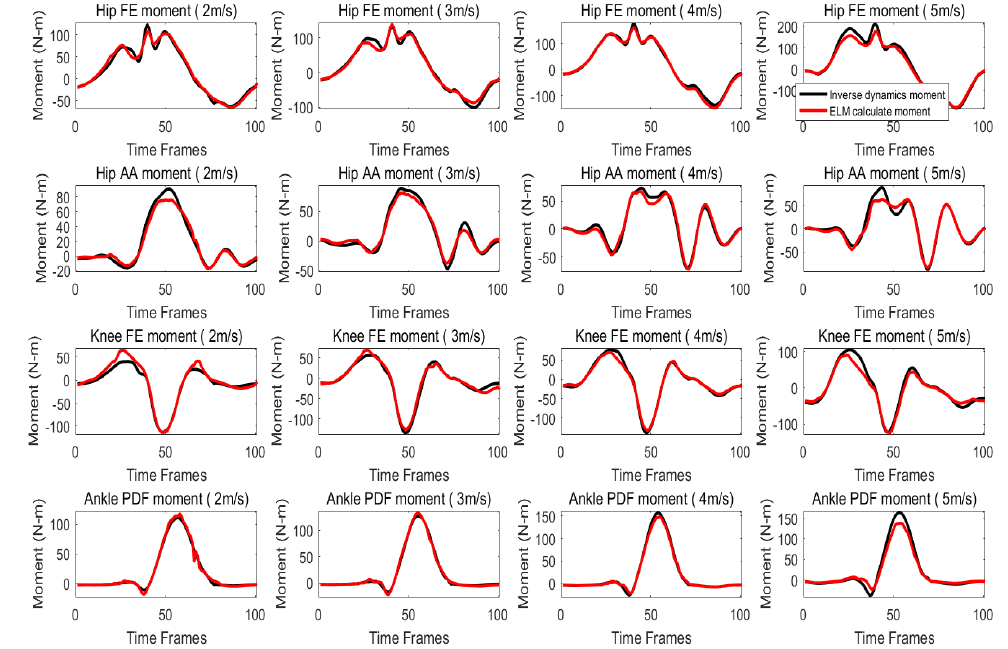
Figure 5. Joint moment prediction of a typical subject at each speed when all four speeds are used for training (level 1). Table 2. Joint moment prediction performances for level 1, evaluated by VAF (%).